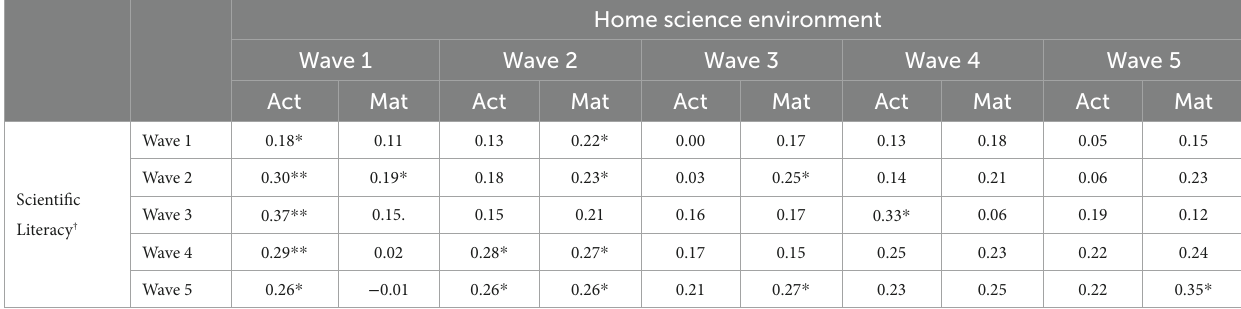
TABLE 10 Bivariate correlations for home science activities, home science materials, and scientific